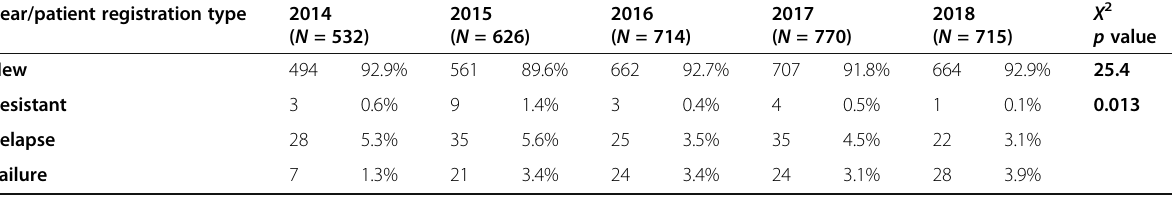
Table 3 Distribution of cases according to patient registration type during the study